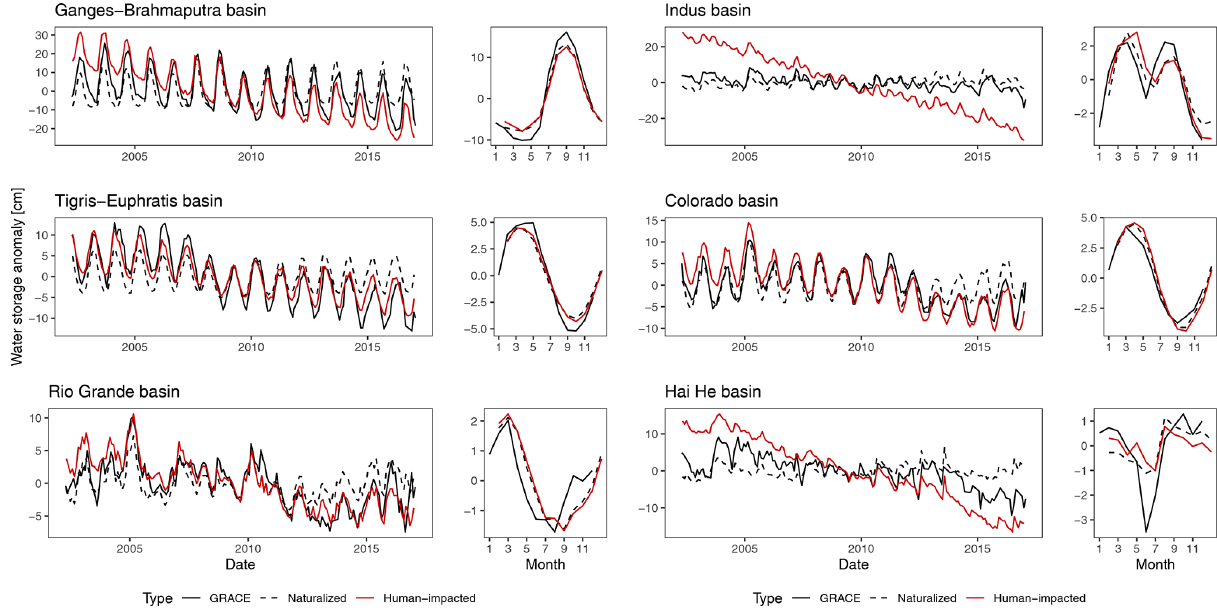
Figure 5. Comparison between simulated monthly terrestrial total water storage anomalies and GRACE-observed values. Panels indicate the time series and multiyear mean averages for naturalized simulations (dashed), anthropogenically impacted simulations (red), and observed (black) terrestrial total water storage anomalies. Table 2. Average annual global groundwater withdrawals and depletion as calculated by several global hydrological